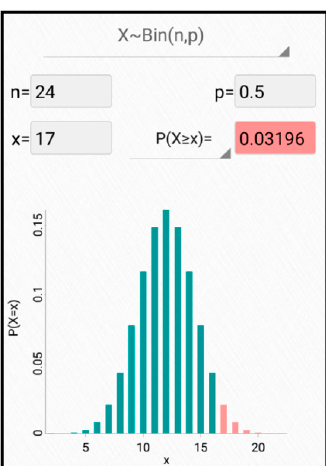
Figure 6. Binomial distribution of the times spent by the participants.